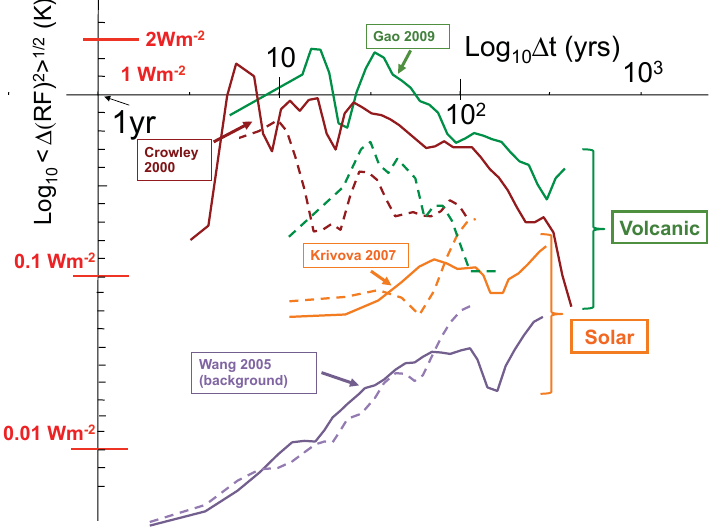
Fig. 9. Radiative forcings from various solar and volcanic reconstructions: a comparison of RMS Haar fluctuations for two solar and two volcanic radiative forcing reconstructions ( R F ; units Wm − 2 ). The dashed lines are for the period 1900–present, the solid lines for the period 1500–1900 (volcanic), 1610–1900 (solar). Note that the Wang et al. (2005) curve is only for the background solar forcing (without the 11yr cycle) whereas the Krivova et al. (2007) curve has a 10yr resolution. The volcanic series were from reconstructions of stratospheric sulfates using ice core proxies. All the structure functions have been increased by a factor of 2 so that they are roughly “calibrated” with the difference ( H > 0) and tendency ( H < 0) fluctuations; see Table 4. The basic forcings have roughly the same scaling properties in the industrial and preindustrial period, only the amplitudes of the volcanic forcings are slightly weaker in the recent